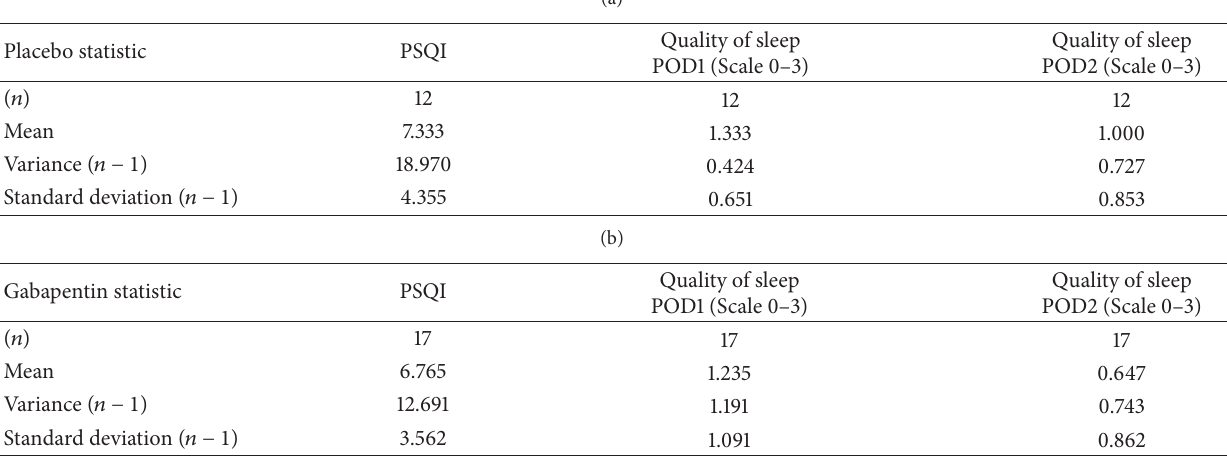
Table 2: The 𝑃 value comparing quality of sleep between the control (a) and Gabapentin (b) groups preoperatively, POD1, and POD